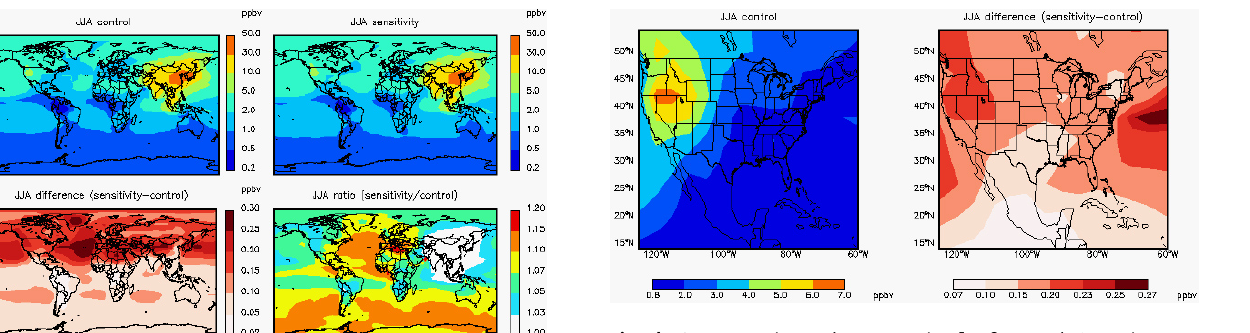
Fig. 4b. Same as Fig. 4a, but zoom-in plot for North